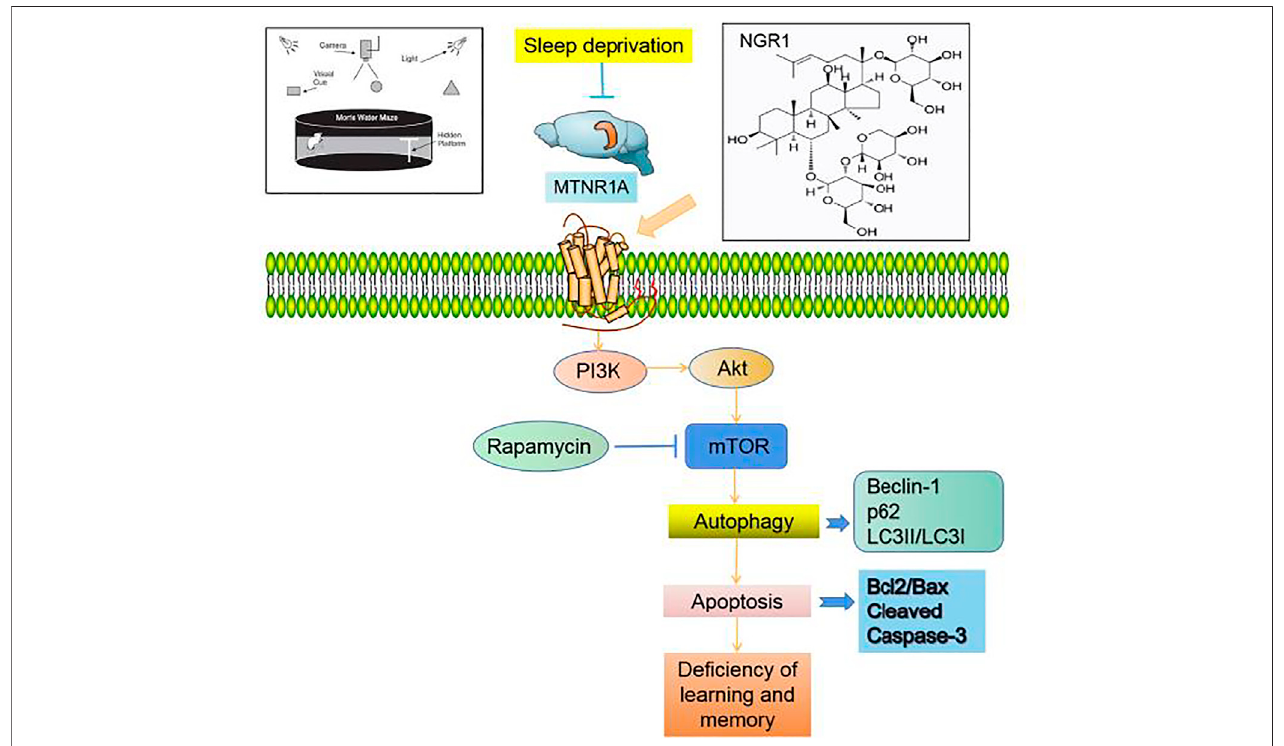
FIGURE 7 | Notoginsenoside R1 reverses abnormal autophagy in hippocampal neuron of mice with sleep deprivation through melatonin receptor 1A.